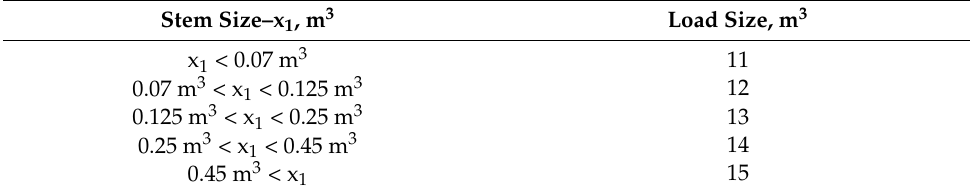
Table 3. Defining of load size of the